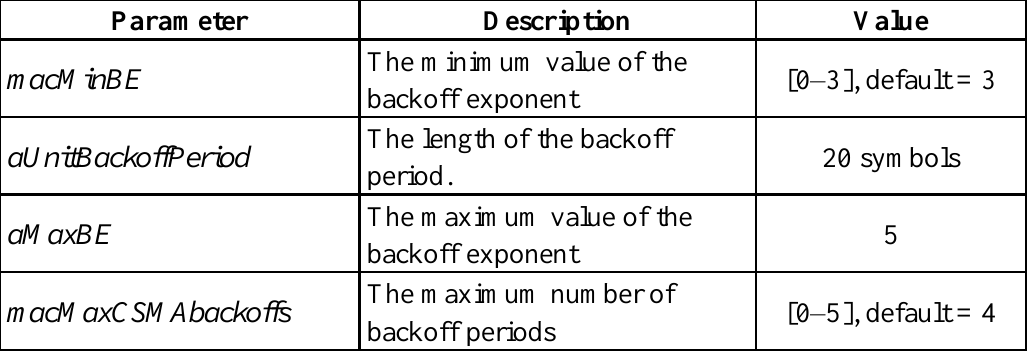
Table 1. Unslotted CSMA/CA